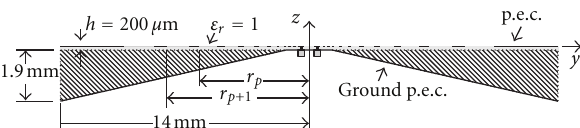
Figure 5: Sinuous antenna over a conical ground plane comprising a dielectric loading.